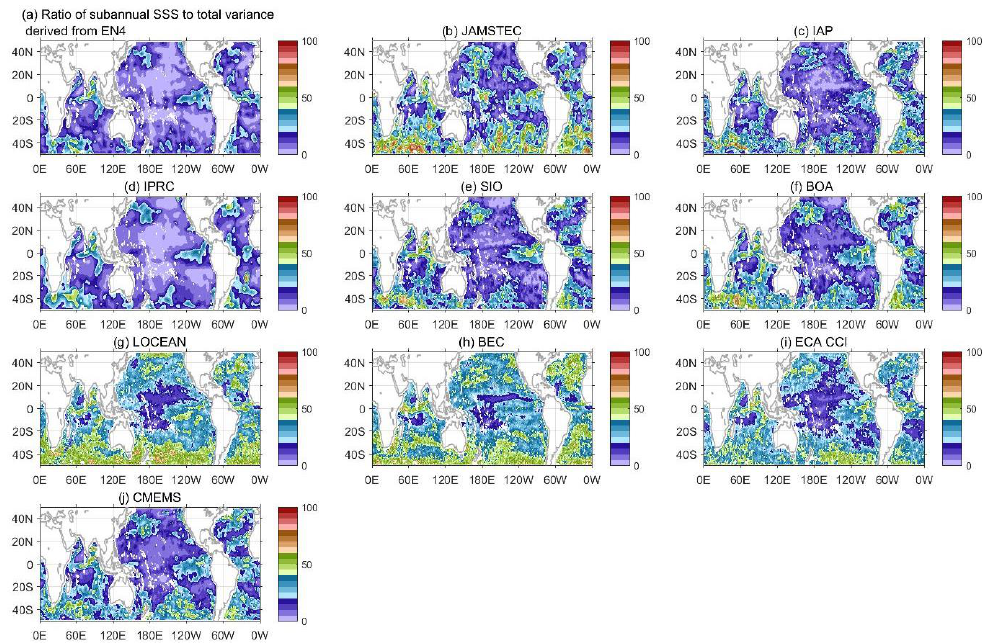
Figure 5. Percentage of the total SSS variance explained by sub-annual variability. To further explore the characteristics of the sub-annual SSS variability over the globe, an EOF is performed for the ten products. There are two cycles in one year in for most of the products (Figure 6), indicating that the semiannual cycle is the leading mode of the sub-annual SSS variances. However, the two cycles in one year show different amplitude, indicating an higher frequency variability contributes to the first mode of the sub-annual SSS. The exceptions are the EN4 (Figure 6b) and IAP (Figure 6c). The EN4 shows one dominant peak and two troughs in one year, and IAP shows multiple peaks and troughs in one year. EN4, IPRC, SIO, BOA, LOCEAN, BEC, ECA CCI, and CMEMS show similar spatial patterns of the first mode by EOF over the tropical oceans (Figure 7). In IAP, negative anomalies spread over extratropical oceans. The first leading mode can account for less than 20% of the total sub-annual SSS variance from each product (Figure 6k), with the largest contribution found in IAP (18%). As mentioned above, the differences in the temporal and spatial patterns of the first leading modes for the sub-annual SSS between products are possibly attributed to the differences among products, including temporal sampling, underlying data, and mapping